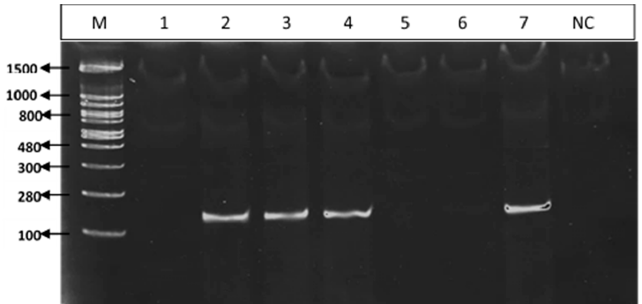
Figure 7. Detection of P. belbahrii in contaminated basil seeds. M—Molecular markers (100–1500 bp). Lanes 1–8: PCR amplification products obtained from: Lane 1—Seeds from healthy plants (Peri) harvested in 2012. Lane 2—Seeds from infected plants (Peri) harvested in 2012. Lane 3—Seeds from infected plants (Sweet Basil) harvested in 2016. Lane 4—Seeds from infected plants (Sweet Basil) harvested in 2017. Lane 5—Seeds from healthy plants (Sweet Basil) harvested in 2016. Lane 6- Seeds from healthy plants (Sweet Basil) harvested in 2017. Lane 7—Positive control, PCR amplification product (134 bp, arrow) obtained from sporangia of P. belbahrii. NC—negative control, water. Table 3. Seed transmission of downy mildew caused by Peronospora belbahrii in basil plants. Disease Transmission Plants Assayed by PCR Experiment Year Seeds Sown Infected Plants